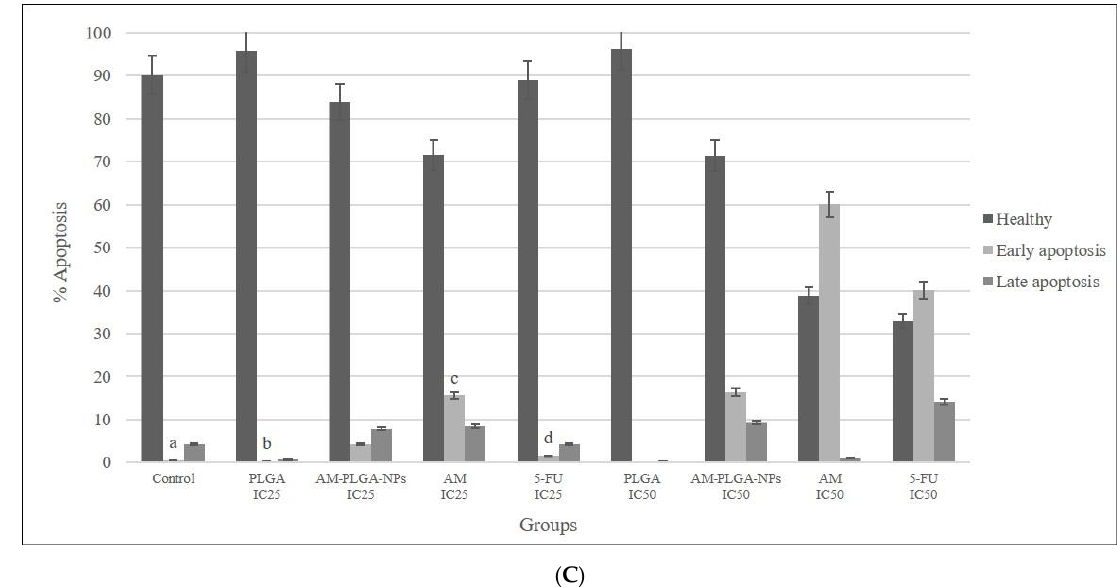
Figure 3. Induction of the apoptosis in the human CCA cell lines ( A ) HuCCT-1, ( B ) CL-6, and ( C ) normal cell line OUMS-36T-1F in the untreated cells, and the cells exposed to free AM, AM-PLGA- NPs, blank PLGA nanoparticles (PLGA), and 5-FU at IC 25 and IC 50 concentrations. Data presented as median (range) of the triplicate experiments.